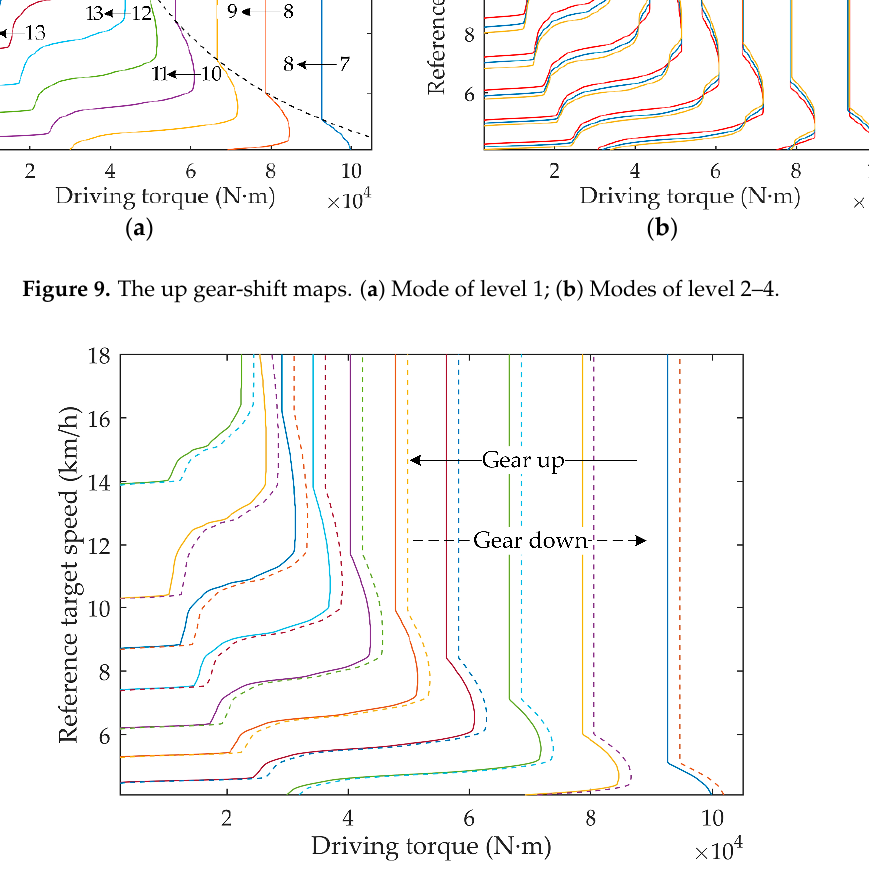
Figure 10. The static gear-shift map for control mode of level 1.